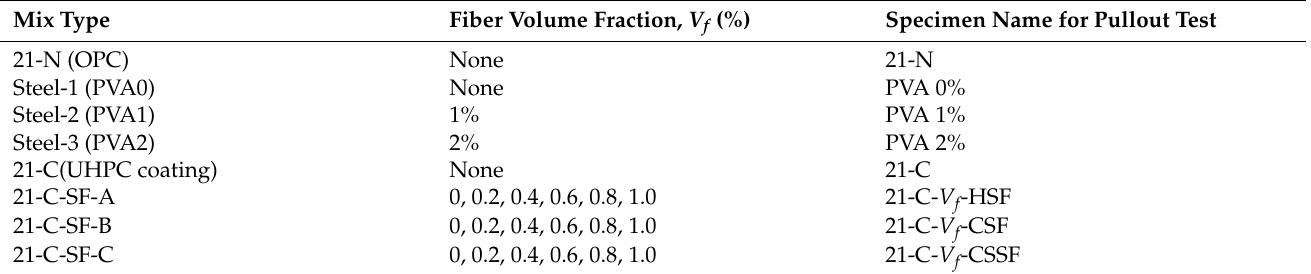
Table 4. Specimens in the pullout